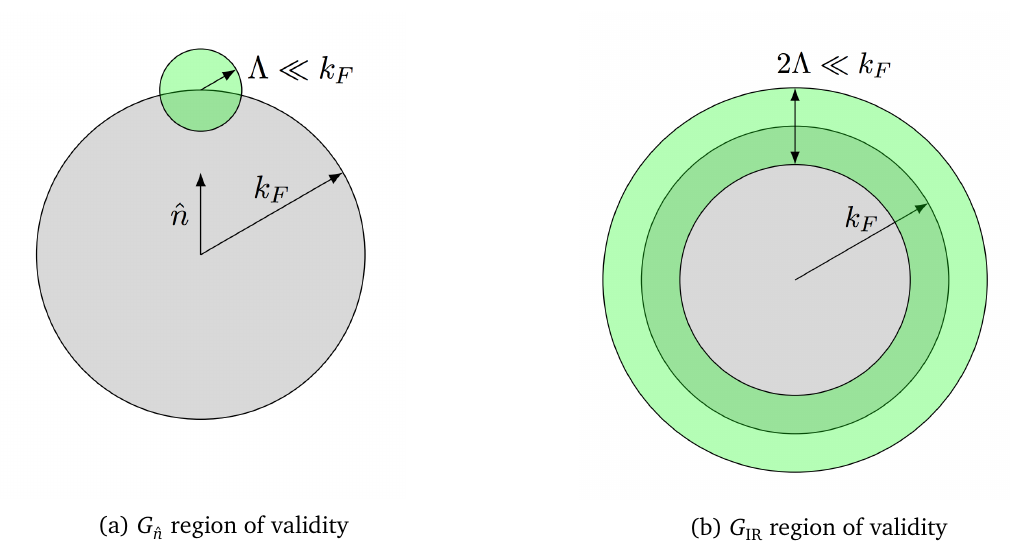
[ φ ] (a) and G [ φ ] (b) are accurate. The boundary of ˆ n IR